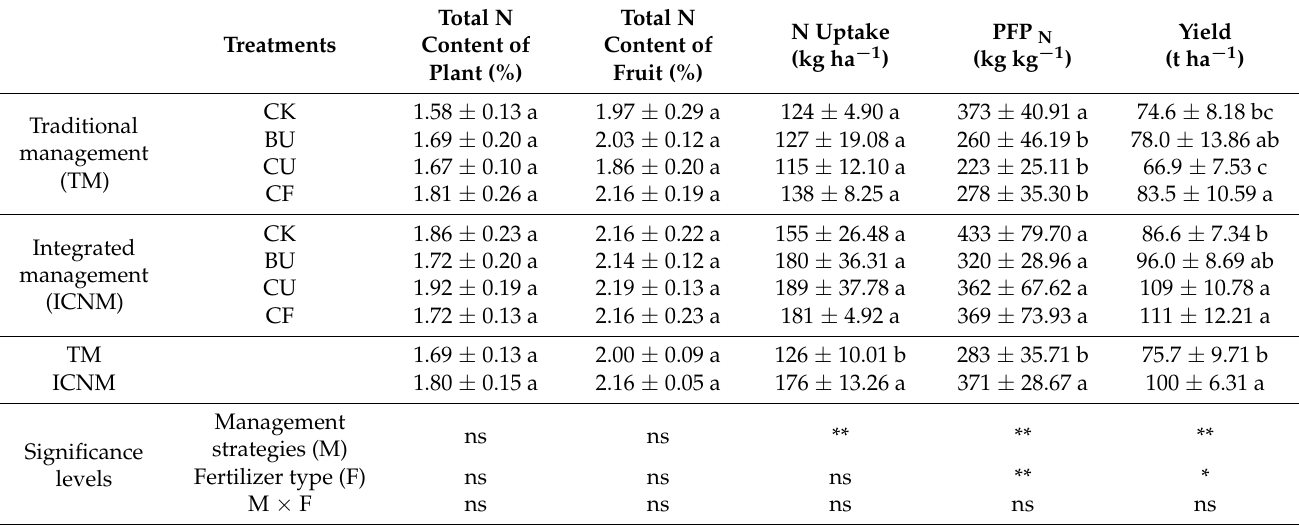
Table 2. Effects of different treatments on plant N utilization and yield of